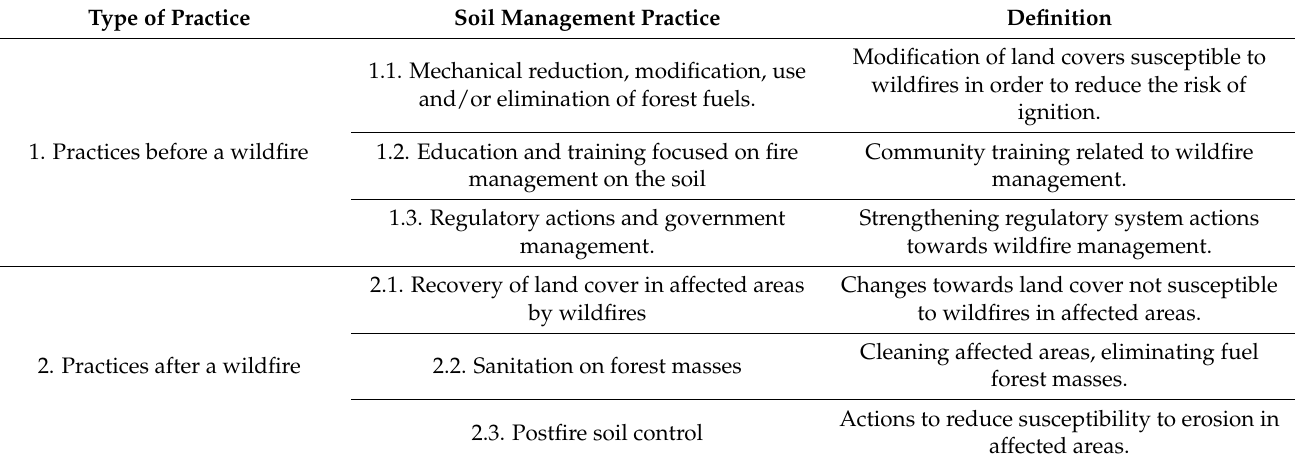
Table 4. List and definition of Soil Management Practices (SMP) chosen for before and after a fire event. Prefire event practices are management and public-policy type, while postfire practices are management type